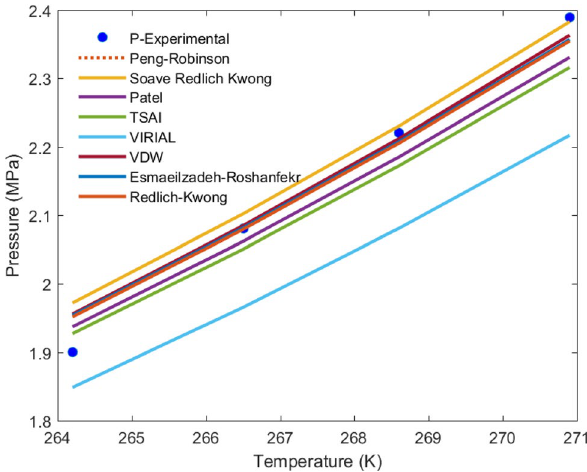
Fig. 5 Predicted pressure versus experimental plot for I – H – V phase region, AAD %, [Min/Max] of [4.5/7.6]